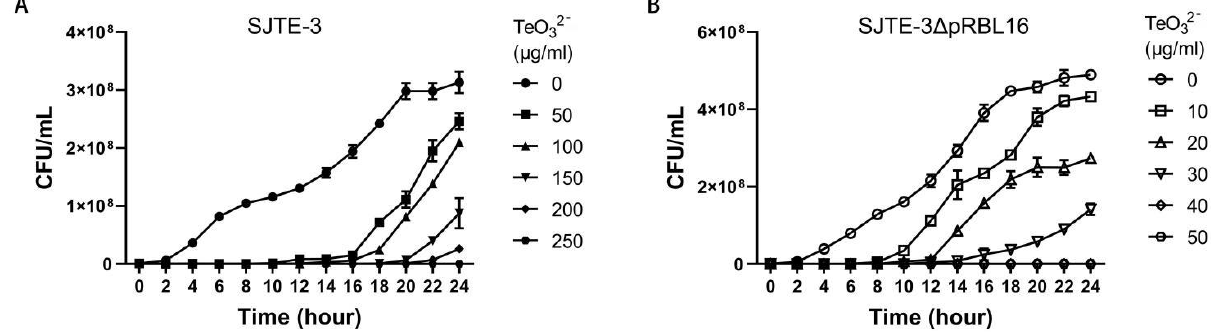
Figure 1. The cell growth curves of P. citronellolis SJTE-3 and SJTE-3 ∆ pRBL16 cultured with tellurite of different concentrations. Strain SJTE-3 ( A ) and strain SJTE-3 ∆ pRBL16 ( B ) were cultured in liquid media with tellurite (from 0 to 500 µ g/mL) and solid plates with tellurite (from 0 to 500 µ g/mL). The cell growth was detected every 2 h and showed in CFU/mL. Three independent experiments were performed and the average values were calculated with standard